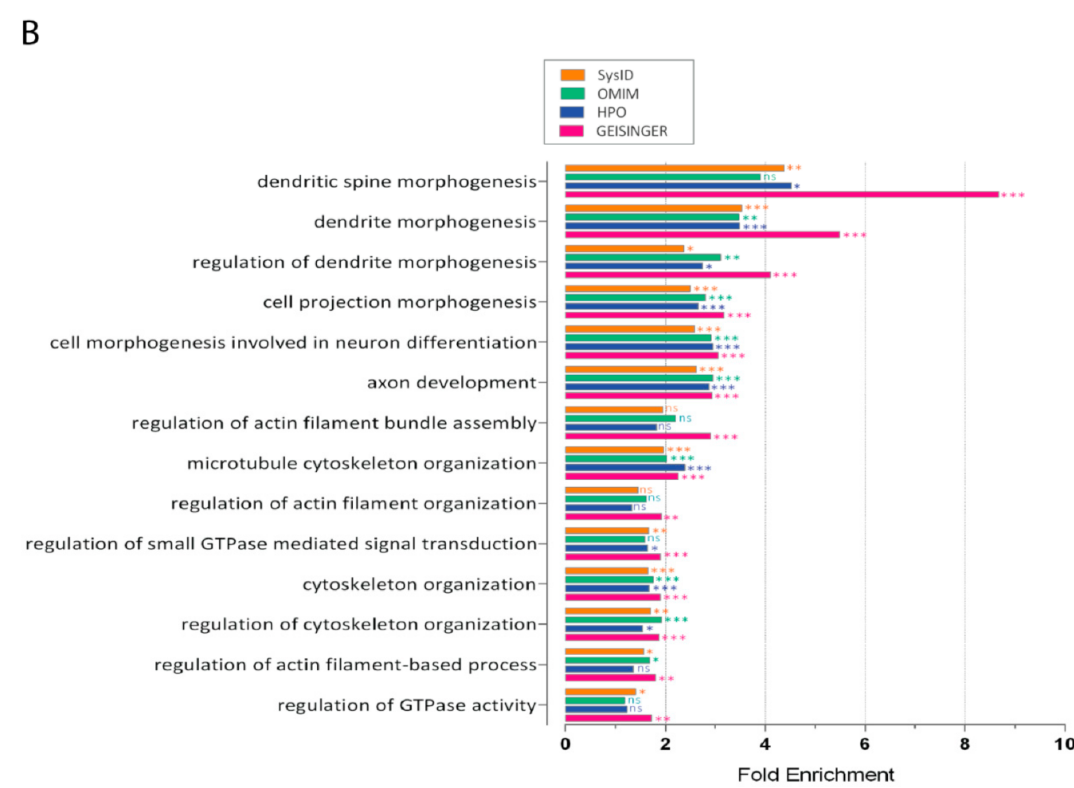
Figure 1. Core regulations in intellectual disability. ( A ). Deregulated biological processes identified in ID. The scheme illustrates the main intracellular processes identified via integrated analyses and their subcellular localization within hypothetical excitatory (in purple) and inhibitory (in blue) neurons. For each process, a few representative ID genes are reported. ( B ). GO terms [12,13] enrichment for ID-associated genes. The terms reported referring to biological processes linked to cytoskeleton activity and regulation. Four databases provided the list of ID-associated genes: HPO (Human Phenotype Ontology, in blue) [58], GEISINGER (in red) [59], OMIM (Online Mendelian Inheritance in Man, in green) [60], and SysID (in orange) [1]. *, **, and *** indicate p < 0.05, <0.01, and <0.001 respectively. n.s., not